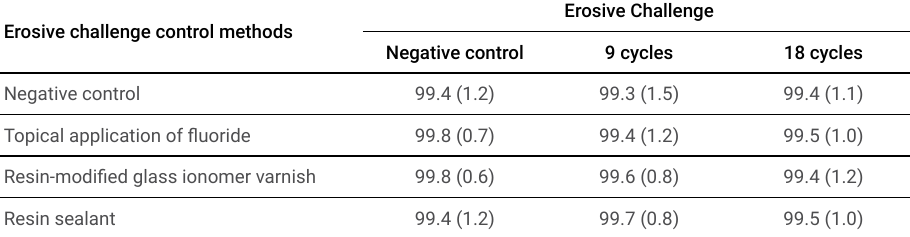
Table 2. Mean (standard deviation) of experimental groups – Internal